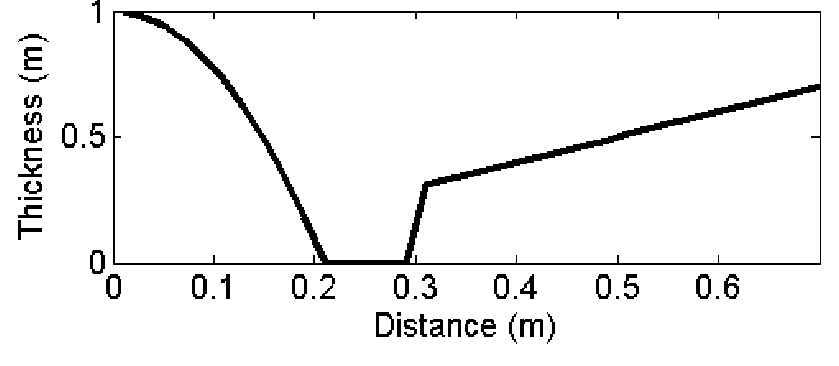
Figure 4. Example function t(d,0.21,0.30)